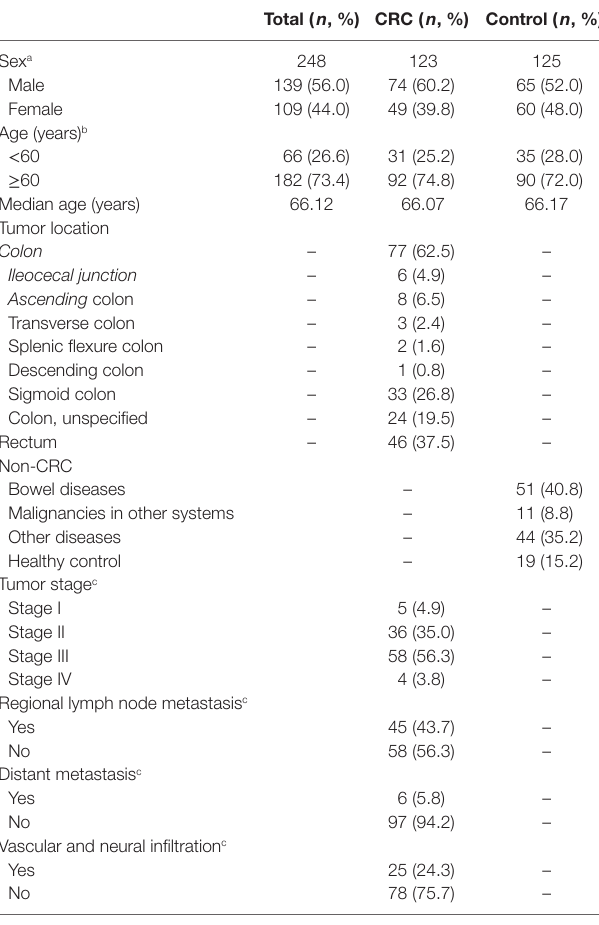
TaBle 4 | Detection sensitivity of fecal occult blood test (FOBT), mSEPT9 , and the combination for the stratification by tumor location (%).